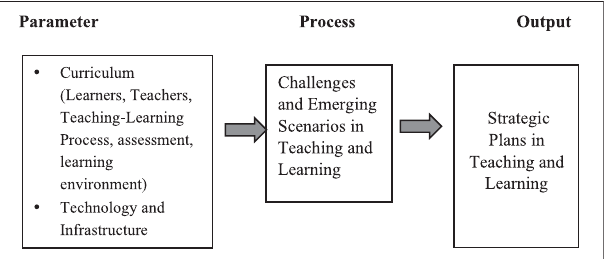
FIGURE 1 | Schematic diagram of the conceptual